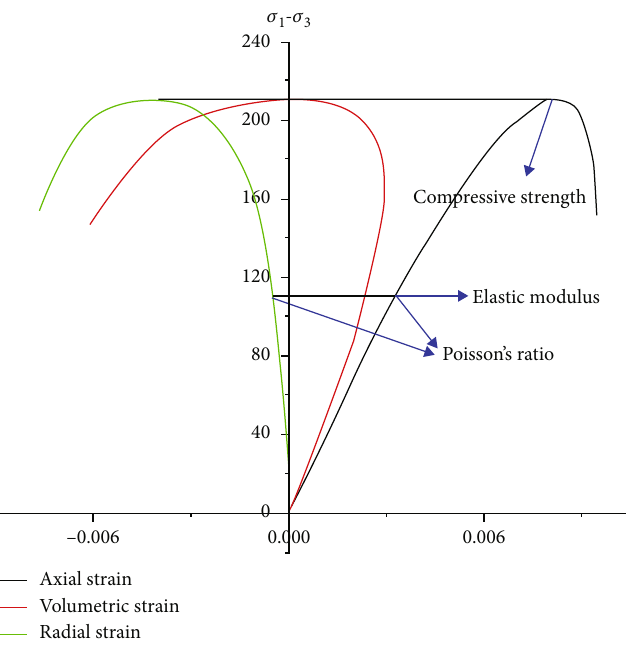
Figure 2: Schematic diagram of stress-strain curve.